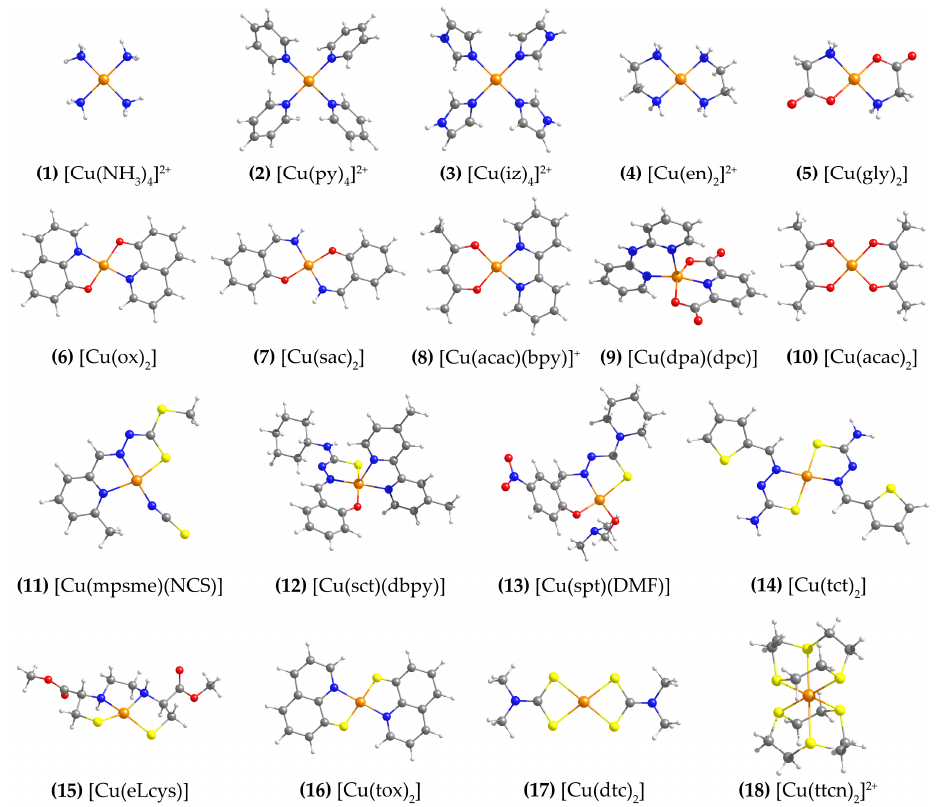
Figure 1. Structures of the eighteen Cu(II) complexes studied in this work. Ligand abbreviations: py = pyridine; iz = imidazole; en = ethylenediamine; gly = glycine; ox = 3 ‐ quinolinolato; sac = salicylaldehyde imine; acac = acetylacetone; bpy = 2,2 ′‐ bipyridine; dpa = 2,2 ′‐ dipyridylamine; dpc = dipicolinate ligand; mpsme = anionic form of the 6 ‐ methyl ‐ 2 ‐ formylpyridine Schiff base of S ‐ methyldithiocarbazate; sct = N(4) ‐ cyclohexyl thiosemicarbazone; dbpy = 4,4 ′‐ dimethyl ‐ 2,2 ′‐ bipyridine; spt = 5 ‐ nitrosalicylaldehyde piperidylthiosemicarbazone; tct = thiophene ‐ 2 ‐ carbaldehyde thiosemicarbazone; DMF = N,N ‐ Dimethylformamide; eLcys = N,N’ ‐ ethylenebis(L ‐ cysteine); tox = 3 ‐ quinolinethiolato; dtc = dimethyl ‐ dithiocarbamate, ttcn = 1,4,7 ‐ trithiacyclononane.